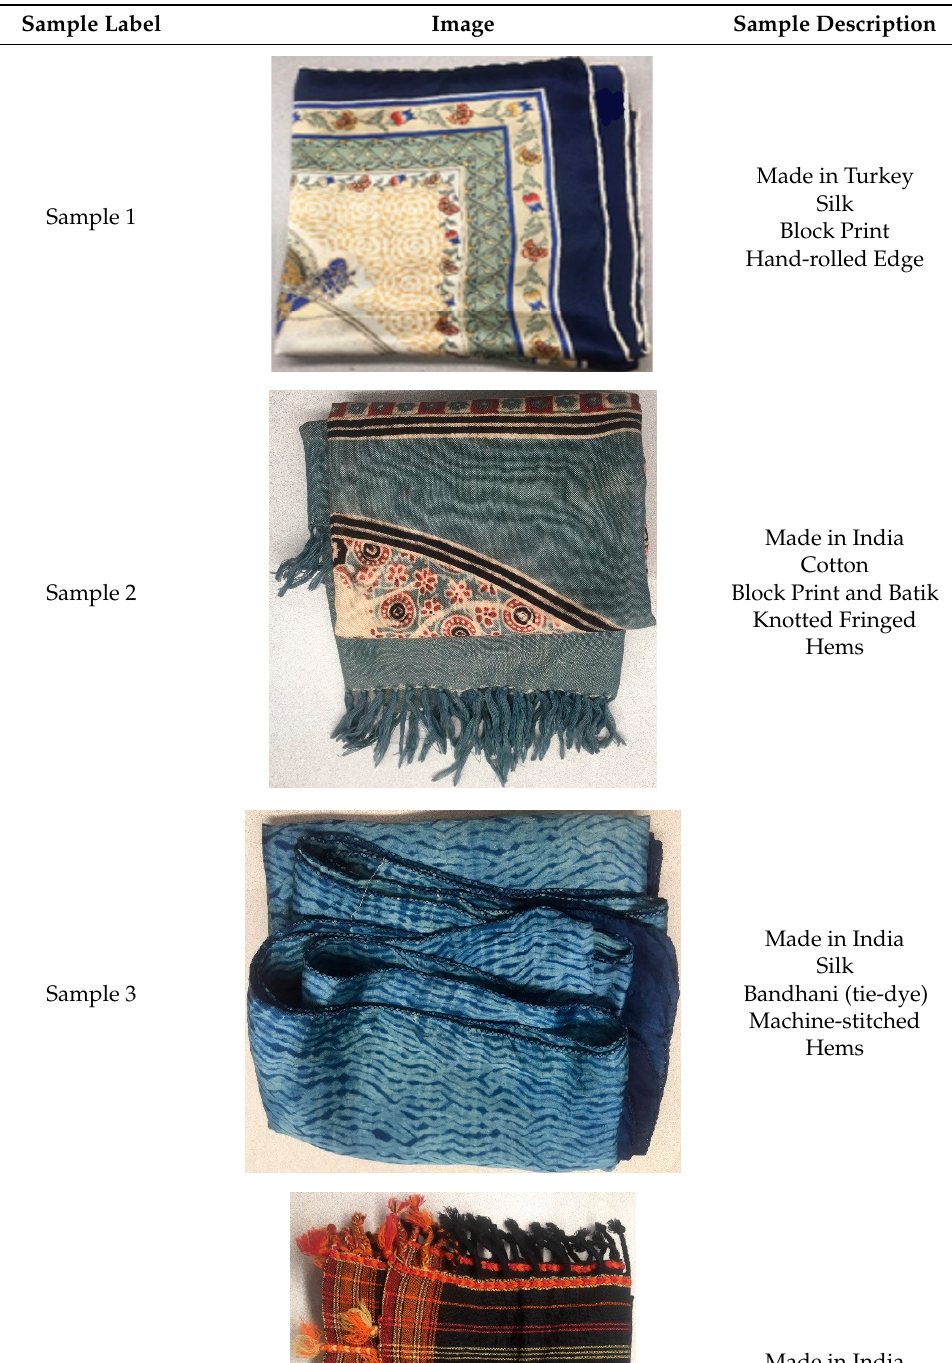
Table 1. Description and images of the ten scarves and shawls that were used as samples during the quantitative consumer